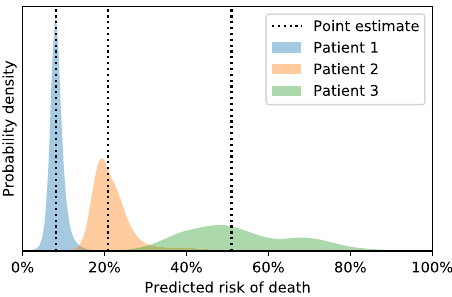
Fig. 1 Point estimates of mortality risk contrasted with predicted distributions over mortality risk. The point estimates from conventional models mask whether our prediction is relatively certain (as in Patient 1) or uncertain (as in Patient 3). The median predicted risk is used as the point estimate in each case. Patients 2 and 3 may have a mortality risk much higher than the median, and the point estimates fail to communicate